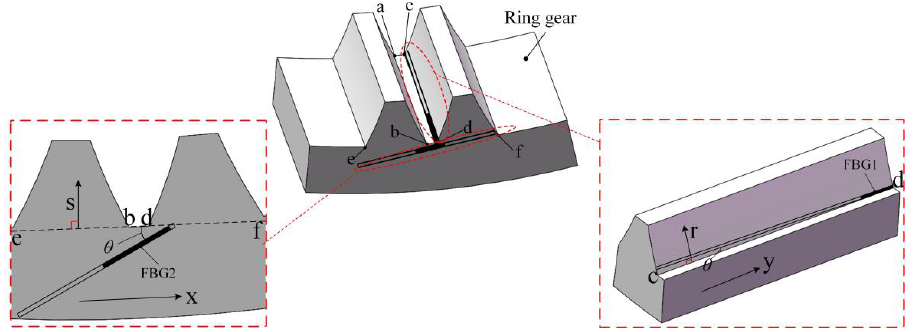
Figure 5. Installation of FBGs.